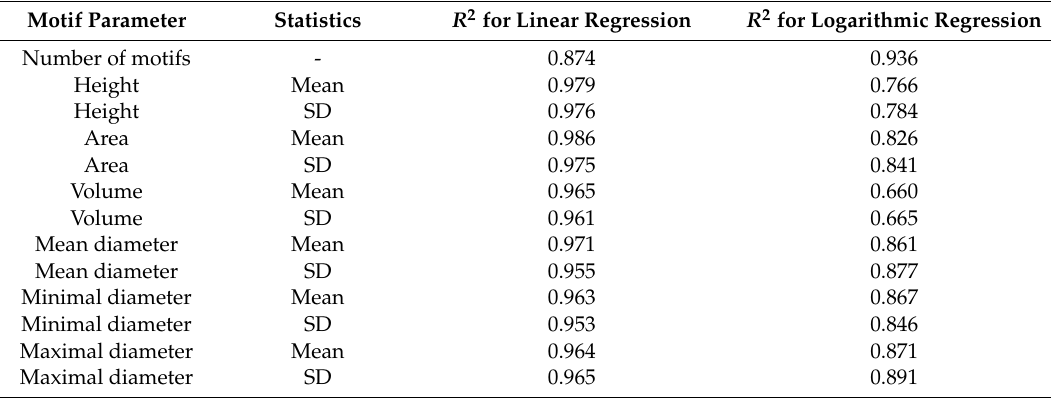
Table A4. Coe ffi cients of determination ( R 2 ) between discharge energies and motif parameters calculated using linear and logarithmic